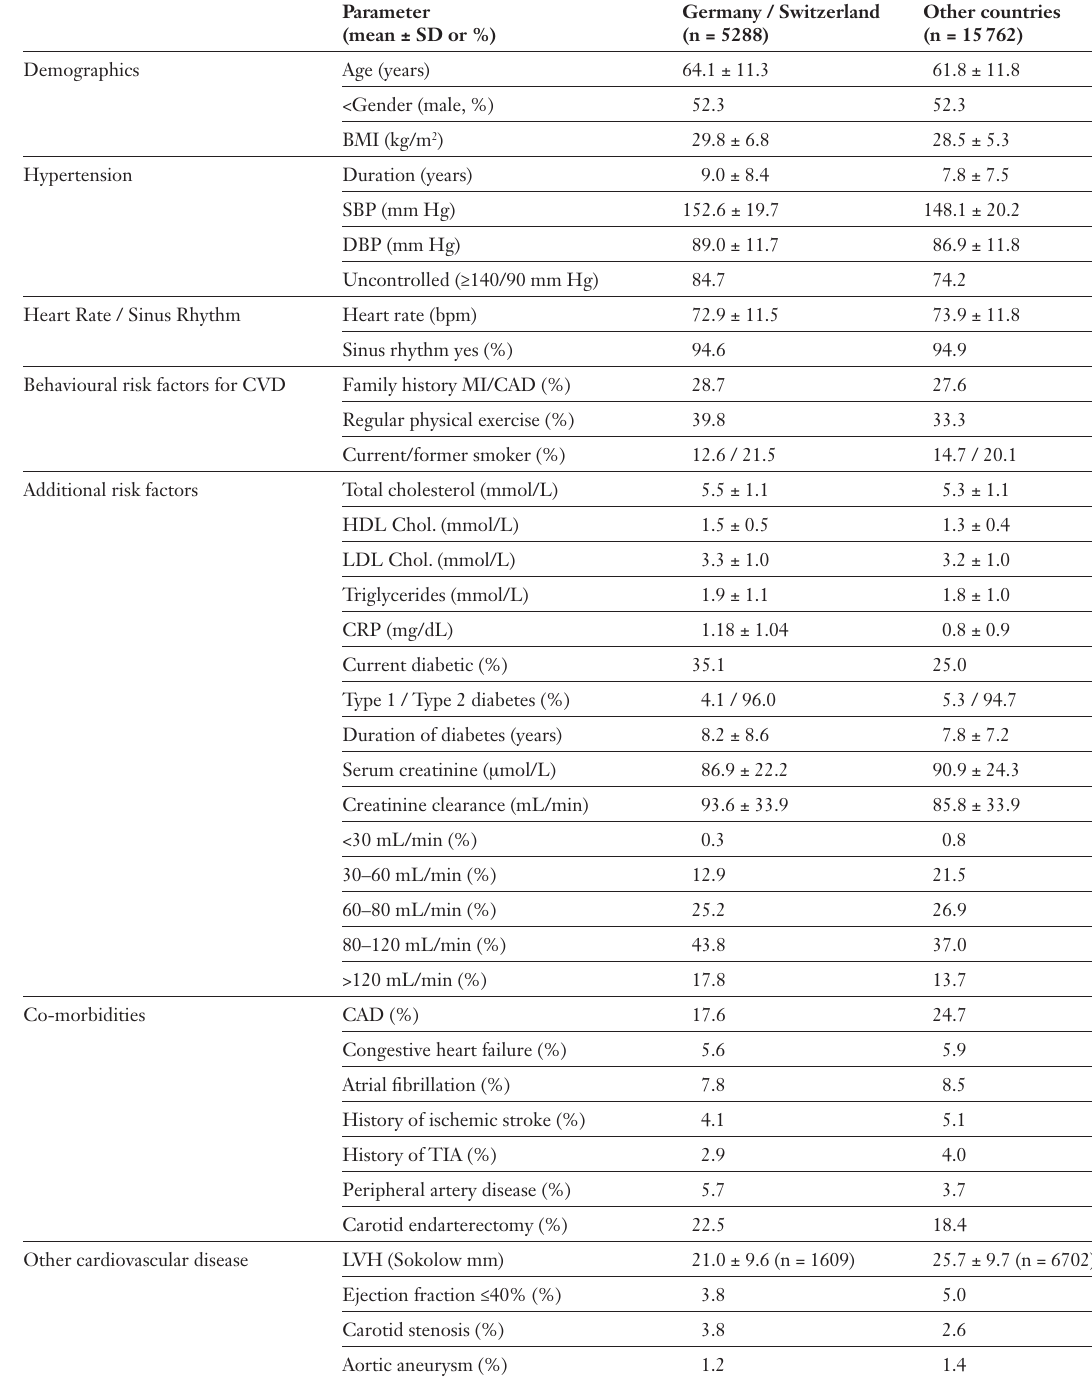
Table 1 Cardiovascular risk profile (Primary analysis